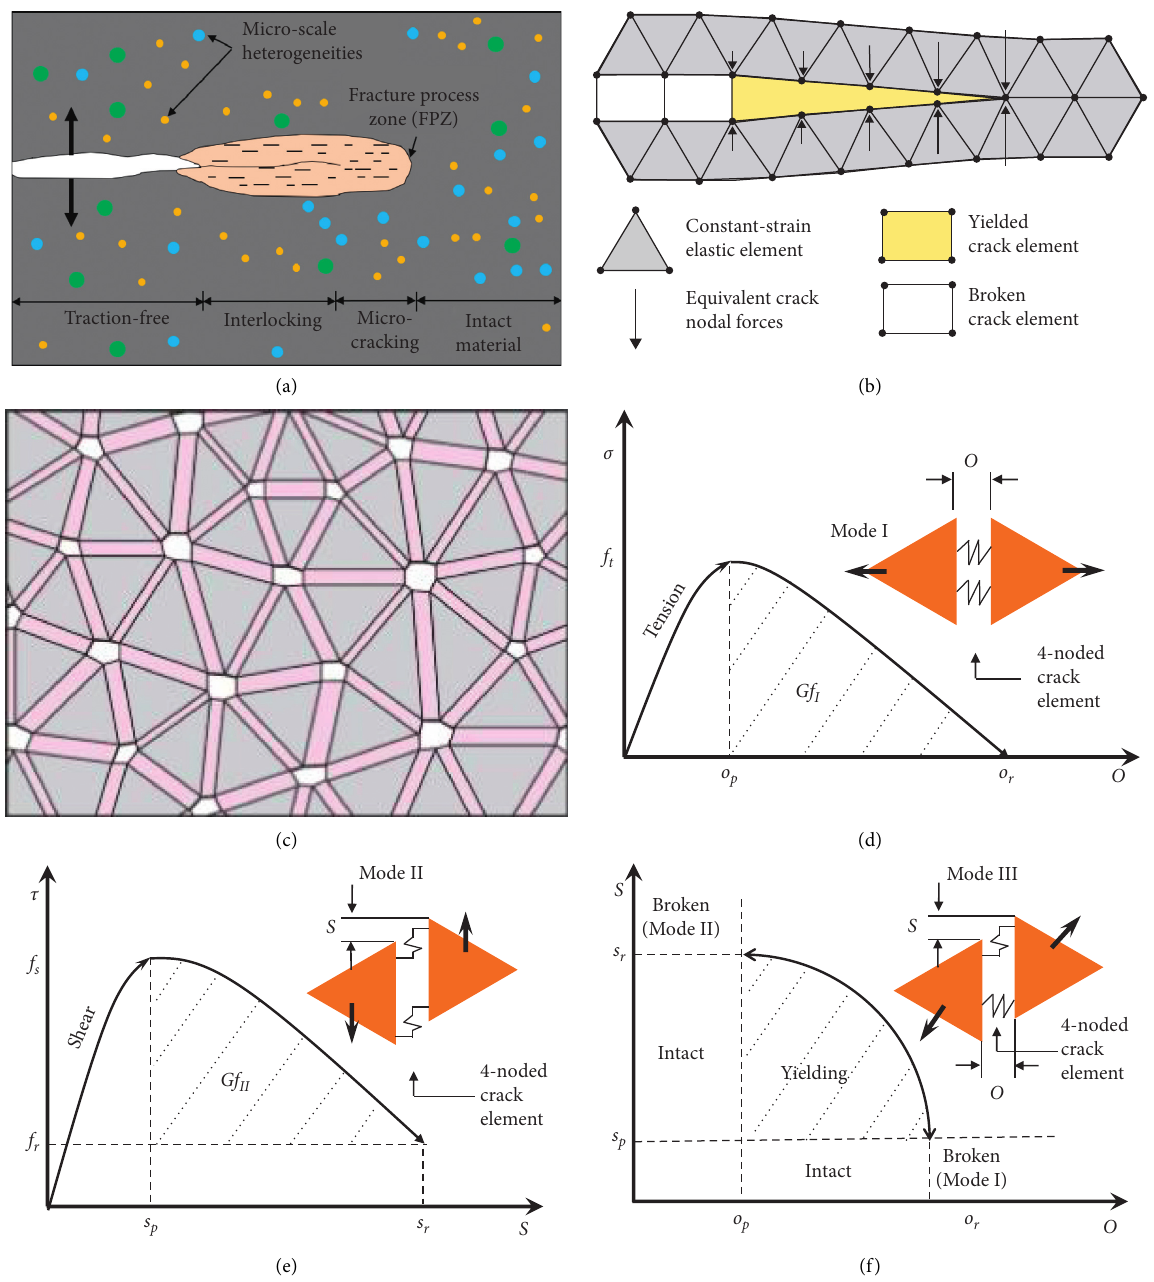
Figure 1: Constitutive models and mechanical principles of cohesive crack element in FDEM: (a) schematic diagram of fracture process zone (FPZ) in brittle rock material; (b) schematic diagram of the numerical FPZ model in Irazu; (c) schematic diagram of 4-noded CCEs and 3-noded triangular elements; (d) tensile fracture mode (mode I); (e) shear fracture mode (mode II); (f) mixed tension-shear fracture mode (mode III) (modified by Zhang et al.